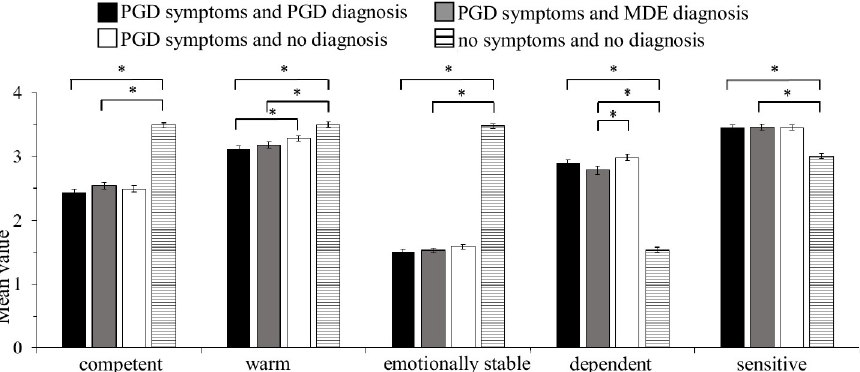
Fig 1. Mean scores and standard error of the mean value by mental health condition for attribute items. Note. Of the five a priori specified contrasts (C1-C5), only significant contrasts are indicated by brackets. ( � adj. p < .01 (Bonferroni-Holm), F -